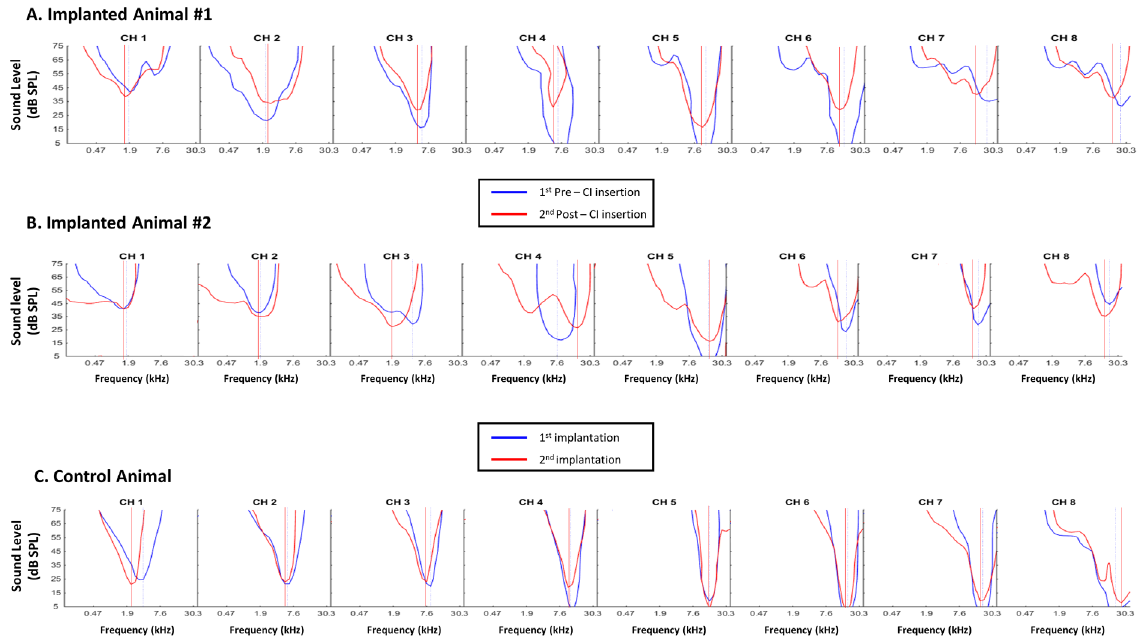
Figure 1. Individual Frequency Response Areas (FRA) obtained before and after cochlear implant insertion ( A , B ) or after two consecutive implantations of the cortical electrodes matrix in a control animal ( C ). For each row in ( A – C ), the curves represent the FRA obtained from 8 different electrodes aligned in the rostro-caudal axis with CH1 located in the most rostral part and CH8 located on the most caudal part of the primary auditory cortex. Each curve was automatically generated from the evoked responses to 33 frequencies (from 0.14 kHz to 36 kHz) presented at 5 to 75 dB and delineates the range of frequencies and intensities that elicited significant evoked responses. ( A , B ) Each blue curve corresponds to the FRA obtained for the 8 electrodes before the cochlear implant insertion and each red curve corresponds to the FRA obtained for the same 8 electrodes after the cochlear implant insertion. In all cases, the CF values obtained before and after insertion are indicated by the dashed vertical lines (blue: before; red: after). In many cases (9/16 in these two examples), the CF values shifted toward lower frequencies and there was also an increase in the threshold at the CF frequency (especially in ( A )). ( C ) Each blue curve corresponds to the initial FRA obtained for a set of 8 electrodes and each red curve corresponds to the FRA obtained after removing the cortical matrix and re-positioning it at the exact same location 30 min later. In all cases, the CF values obtained at the 1st and 2nd placement of the cortical matrix are indicated by the dashed vertical lines (blue: 1st; red: 2nd). In most of the cases (5/8 in these example), the CF values were the same at the 1st and 2nd placement of the matrix and there was also little increase in the threshold at the pre-insertion CF frequency.